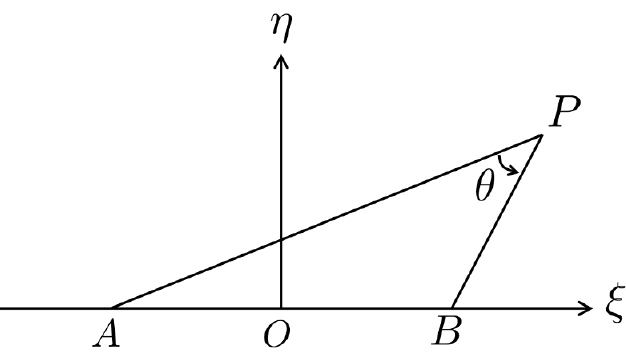
Figure 1 . Bipolar coordinates ( (cid:26); (cid:18) ): (cid:18) = \ APB , (cid:26) = log j AP j = j BP j and j AO j = j BO j = a